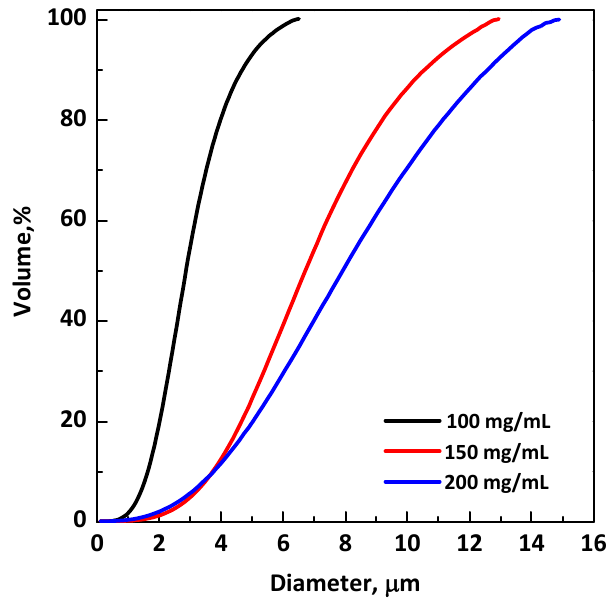
Figure 4. Volumetric PSDs of RUT: β -CD microparticles 1:2 mol:mol; effect of total concentration in DMSO.